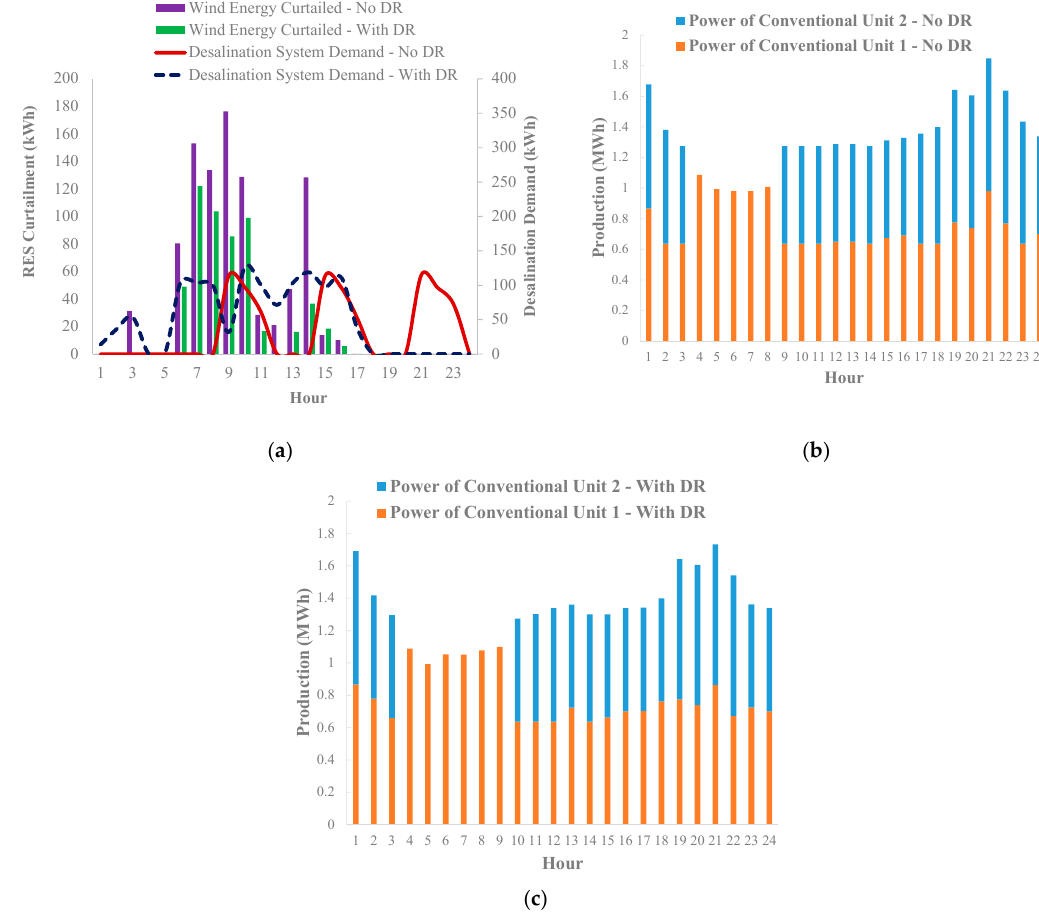
Figure 8. Operation of the desalination system with and without the relevant DR capabilities in 29/08/2019: ( a ) Comparison of the RES curtailment and the desalination system demand, ( b ) operation of the conventional generators without the DR capabilities of the desalination system enabled, and ( c ) operation of the conventional generators when the desalinations system offers demand response services.